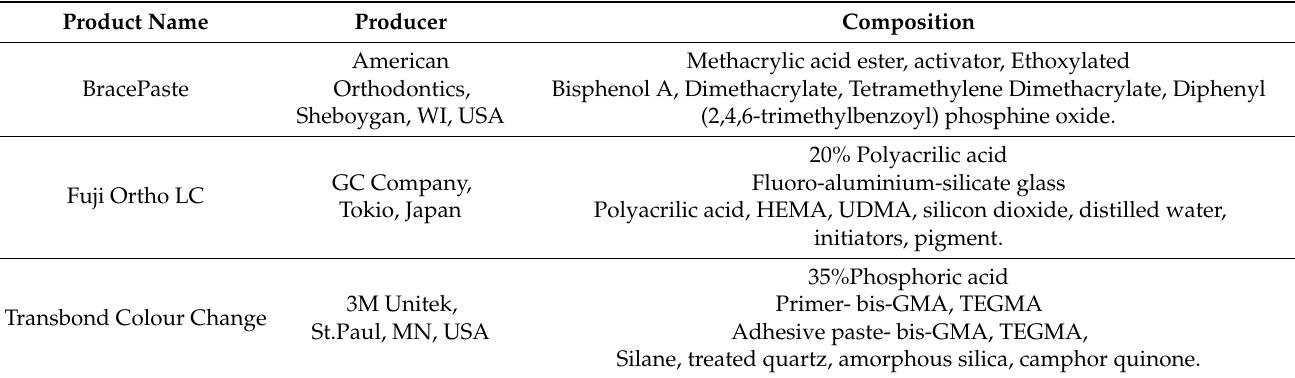
Table 1. Materials